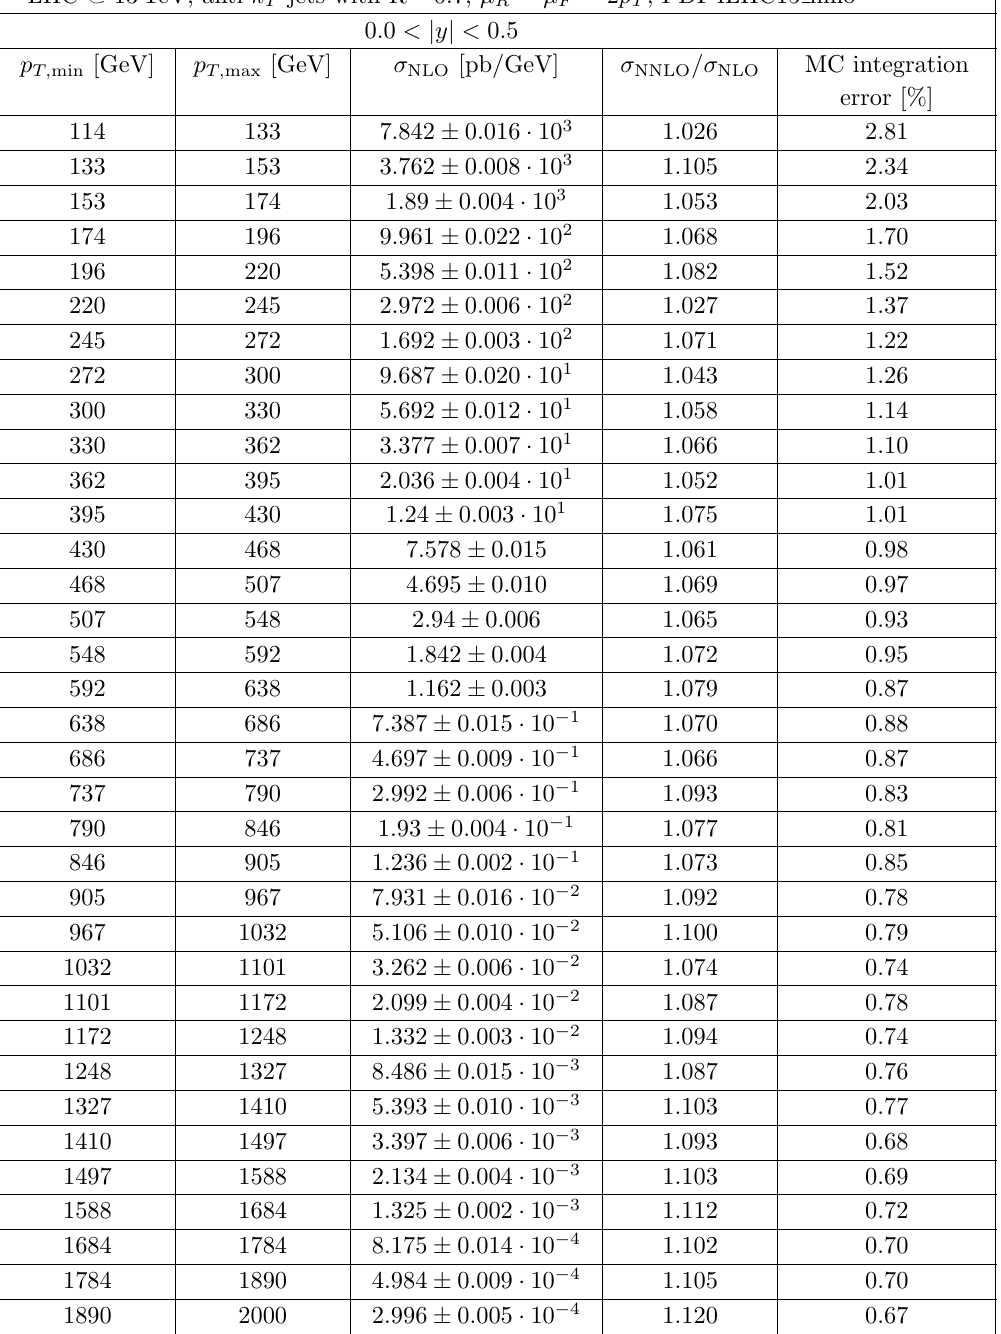
Table 1 . NLO QCD single-inclusive cross section and NNLO QCD K-factors in the rapidity slice y < 0 : 0 : 0 < j j